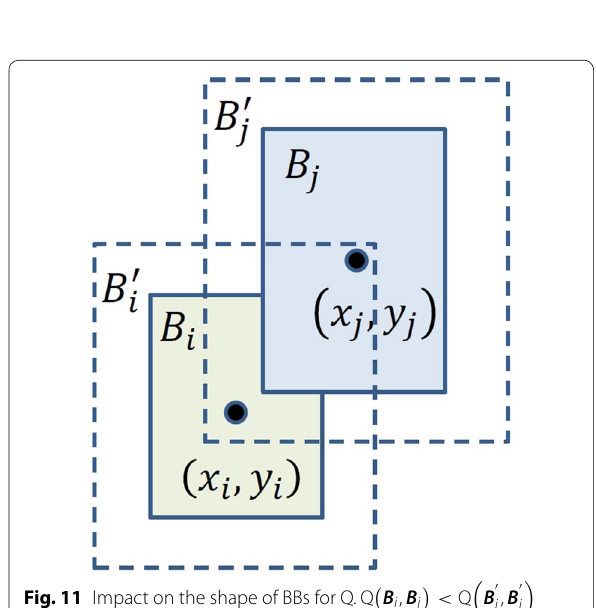
Fig. 11 Impact on the shape of BBs for Q.